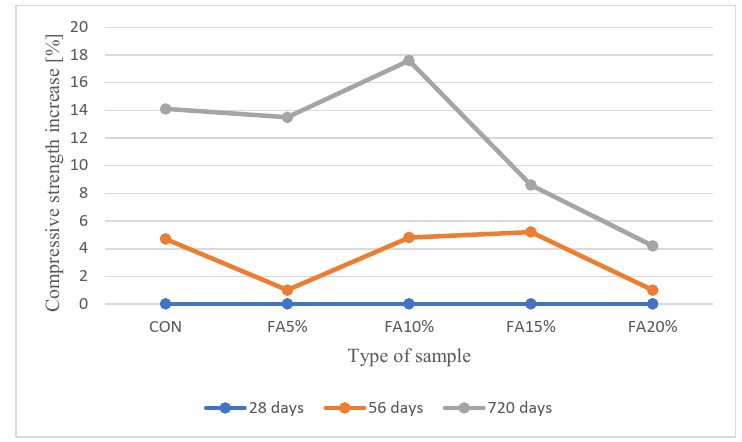
Figure 9. Growth of compressive strength with time.